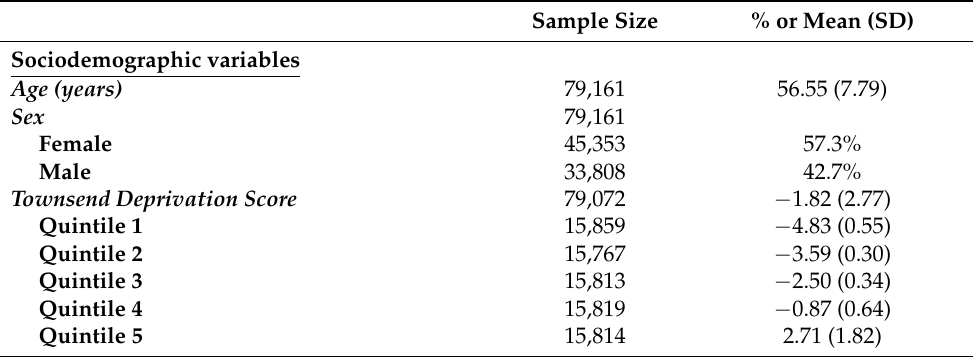
Table 1. Demographics, Health, and Sleep Characteristics of the Study